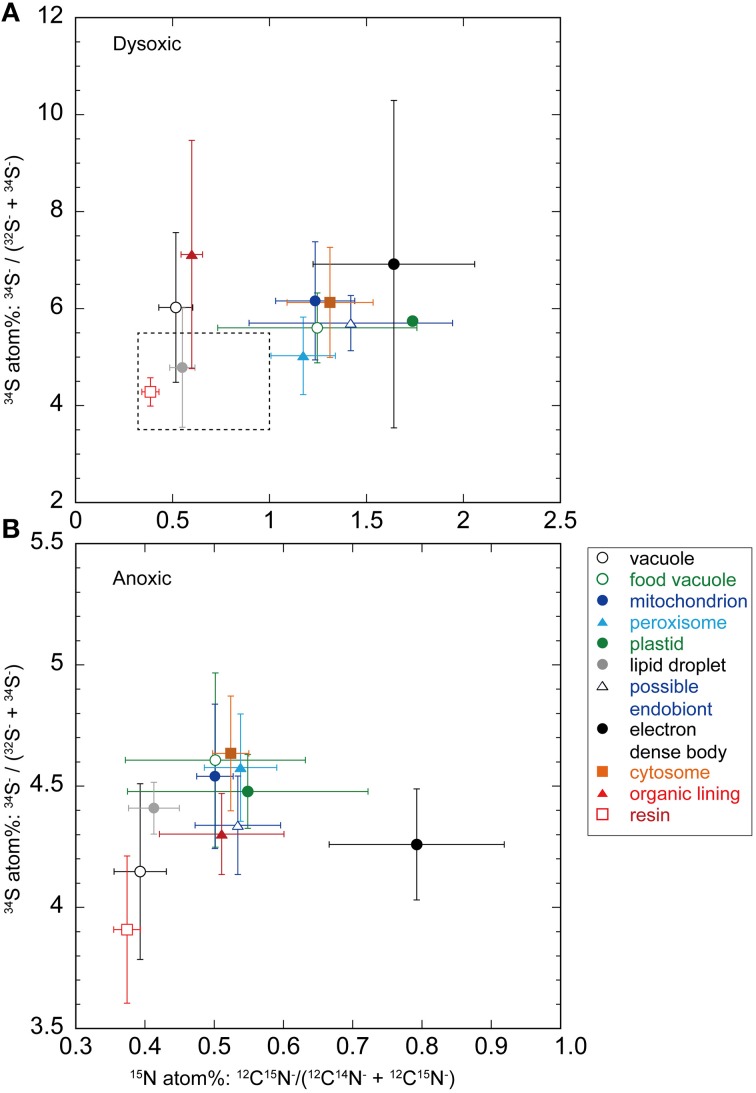
Averaged (± SD) nitrogen and sulfur isotopic compositions (in atomic %) of organelles and ultrastructural features from foraminiferal semi-thin sections (A, dysoxic specimens; B, anoxic specimens). Note different scales on both sets of axes. The dotted box in a corresponds to the same scale that shown in (B).